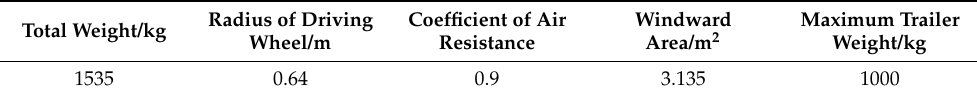
Table 4. Related parameters of electric tractor.